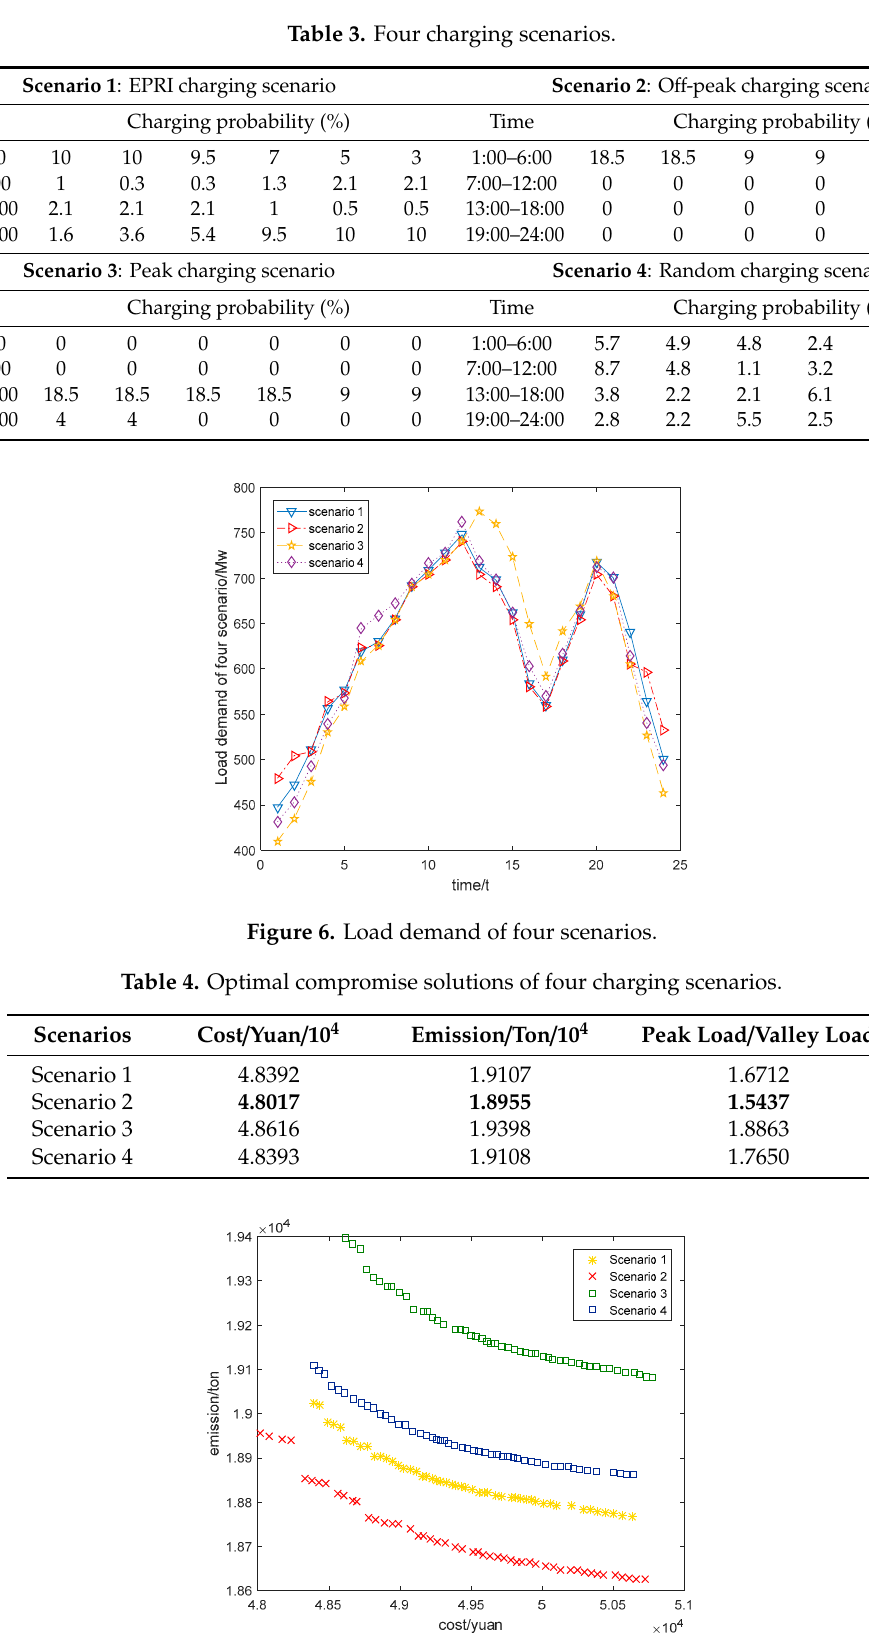
Figure 7. Pareto optimal front (POF) of four charging scenarios.